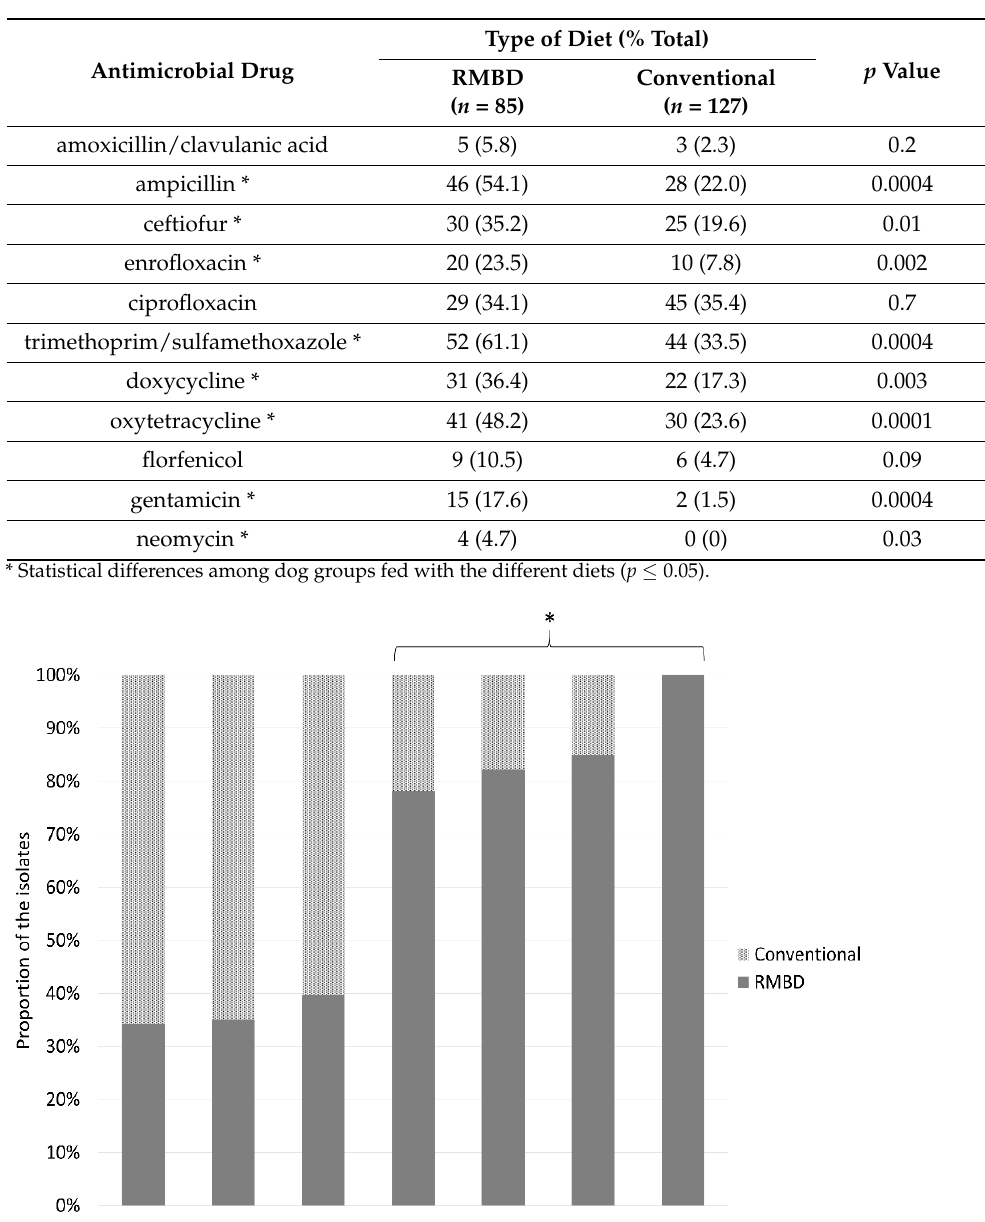
Table 2. Frequencies (%) and p value of resistance to each tested antimicrobial drug in the E. coli strains isolated from dogs fed with raw meat-based diets (RMBDs) and conventional food.